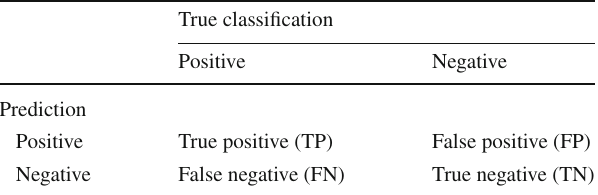
Table 11 Classification of events following from a comparison of true classification and prediction